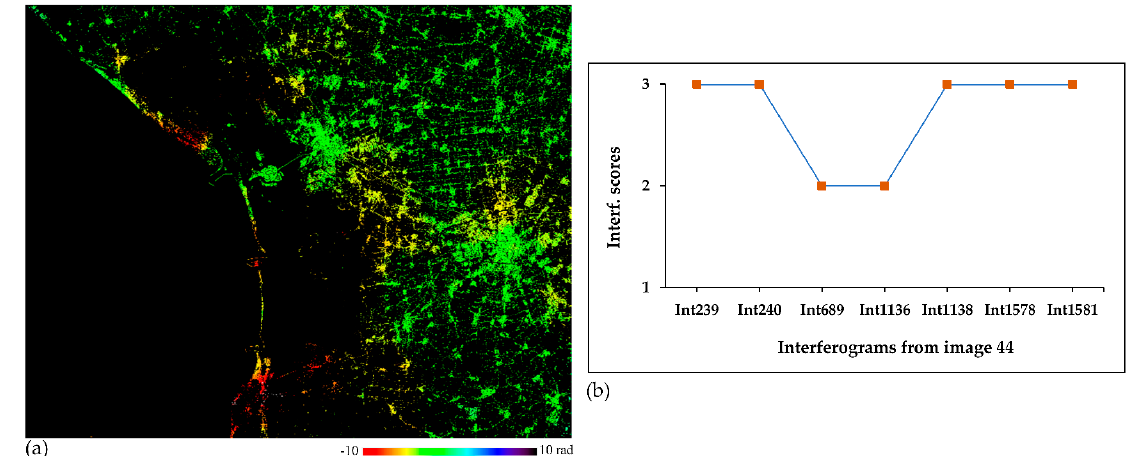
Figure 2. Example of unwrapped interferogram classified in C3 ( a ) and plot of scores of interferograms associated with image 44—the image classified in C3 ( b ). Image 44 displays one of the two images classified in the unreliable class from the total of 263 images. Assessing the interferogram scores of this image, we found that five of the seven interferograms associated with image 44 are classified in C (cid:2871) (Figure 2b). We have also noticed that many of the erroneous measurement points are located in the tour- ist coastland Sottomarina area − bottom part of the scene in Figure 3b.